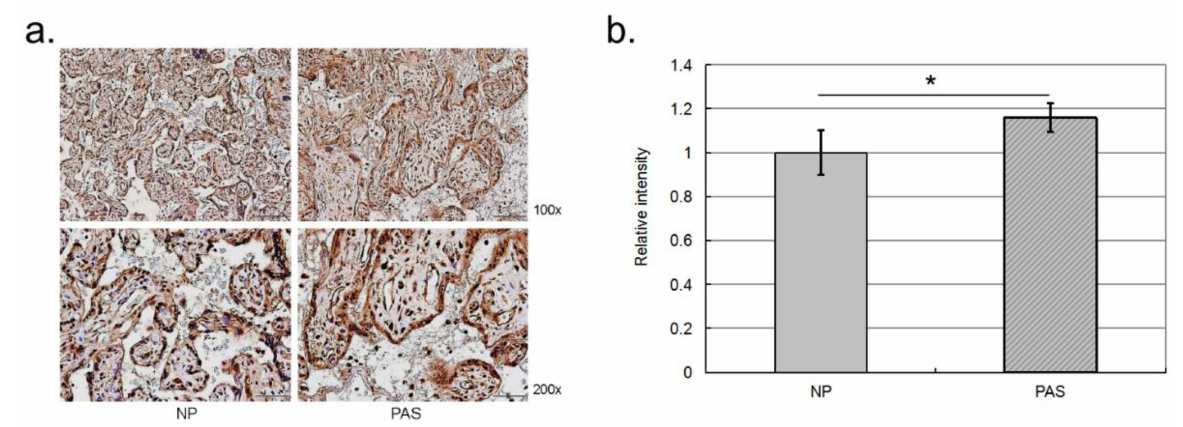
Figure 4. The results of IHC assays. We used IHC assay to examine the abundance of HSPA4 protein among the FFPE trophoblast villous. The scanned images were analyzed with GraphPad Prism 5. ( a ) IHC result on one of the trophoblast villous from one PAS and one normal pregnant subject. ( b ) Quantification result of the placenta samples from five PAS and five normal pregnant subjects. * denoted p -value <